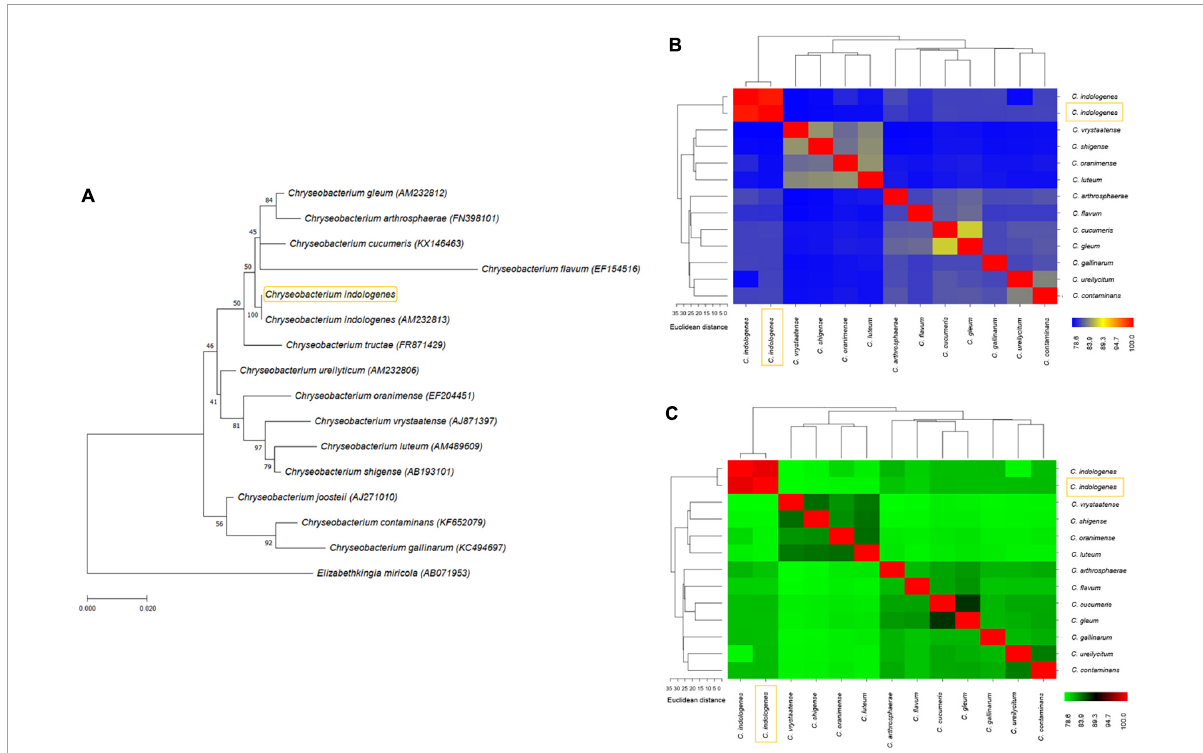
FIGURE3 (A) Phylogenetic tree based on 16S rRNA showing the relationship among our C. indologenes strain and other reference sequences of 16S rRNA obtained from public databases. The number next to the node is the statistical bootstrap value. In brackets are GenBank accession numbers of the 16S rRNA genes. The scale bar indicates 0.020 substitutions per nucleotide position. The heat maps of average nucleotide identity (ANI) ( B ) and in silico DNA–DNA hybridization (DDH) ( C ) between our C. indologenes genome and twelve Chryseobacterium genomes. The yellow box represents our strain.